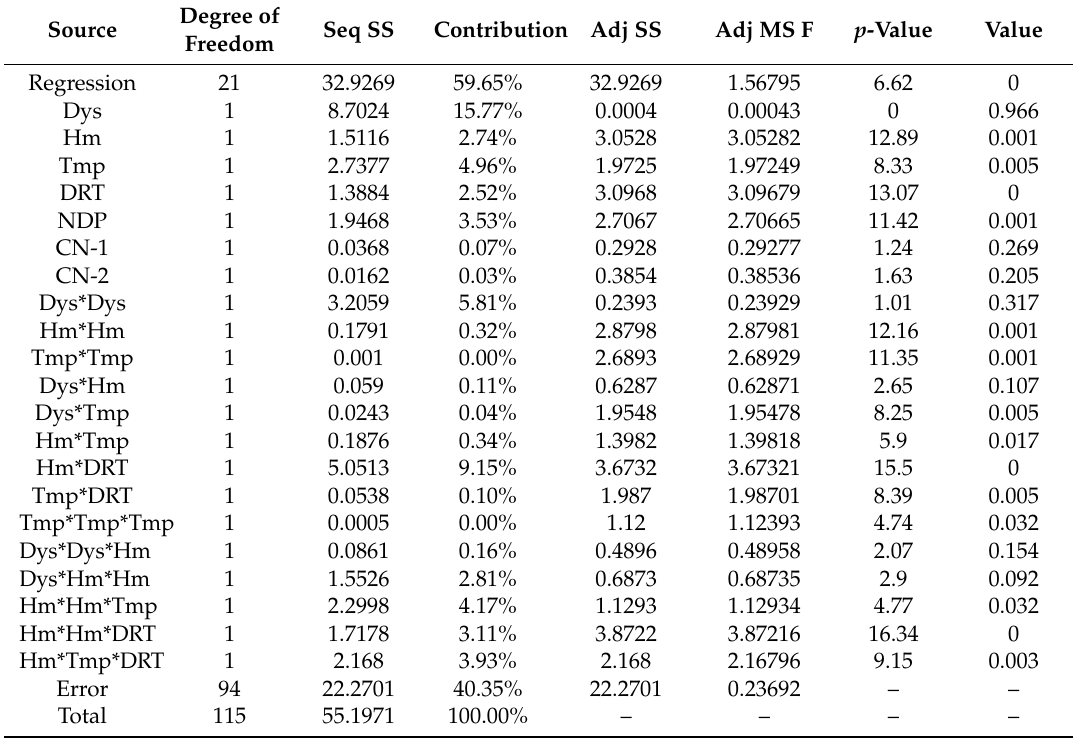
Figure 6. Histogram of residuals.